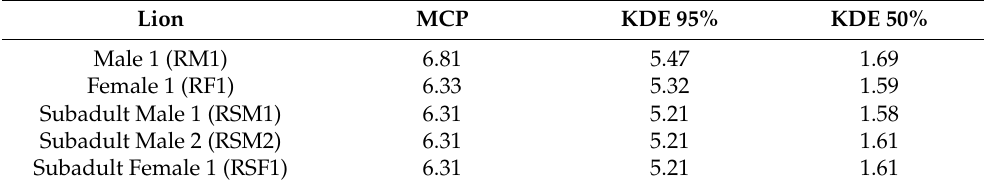
Table 2. Summary of individual home range size per lion (100% MCP, 95% KDE; 50% KDE), for the Royal pride, at the Tula-Tsau Conservation Area, South Africa.